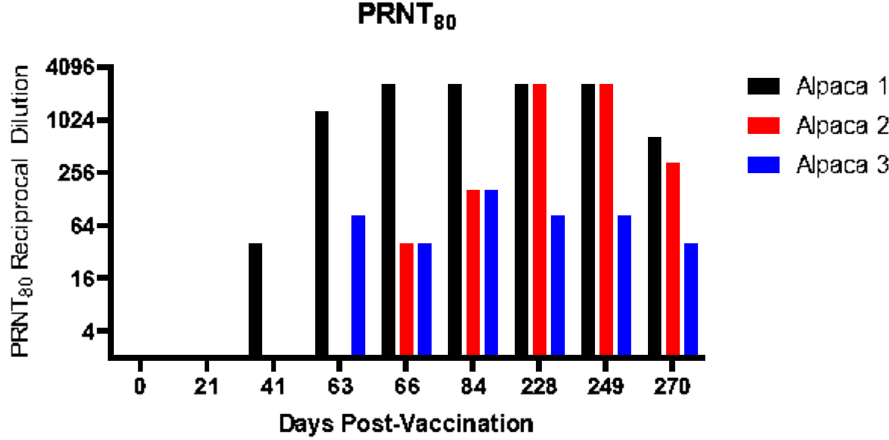
Figure 1. Andes virus neutralizing titers of polyclonal alpaca serum. Serial blood samples were collected from immunized alpacas at the indicated time points and plasma was evaluated using a surrogate VSV-based PRNT assay for neutralization titers.